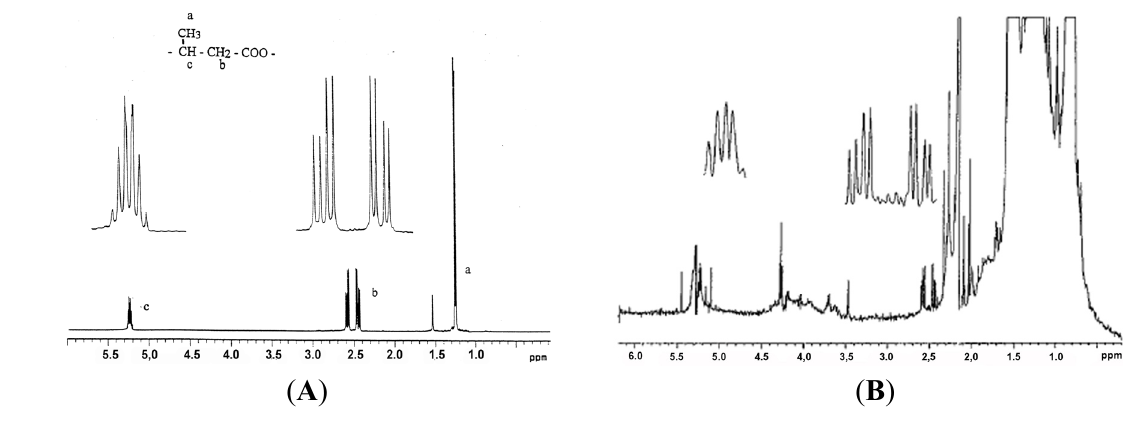
Figure 5. ( A ) 1 H NMR spectra of PHB from Alcaligenes . From Reusch (1992) [13]; ( B ) 1 H NMR spectra of the CHCl3:CH3OH (9:1) extract of the ribosomal fraction of E. coli JM101. The sample shows the characteristic methylene and methine protons of PHB; the methyl protons are hidden under resonances of impurities. Assignments: methylene protons split into an octet at 2.42–2.62 ppm, JAX 5.7, JBX 15.5; methane protons form a multiplet centered at 5.23 ppm. The assignments were confirmed by selective decoupling of the methine resonances. From Huang and Reusch 1996